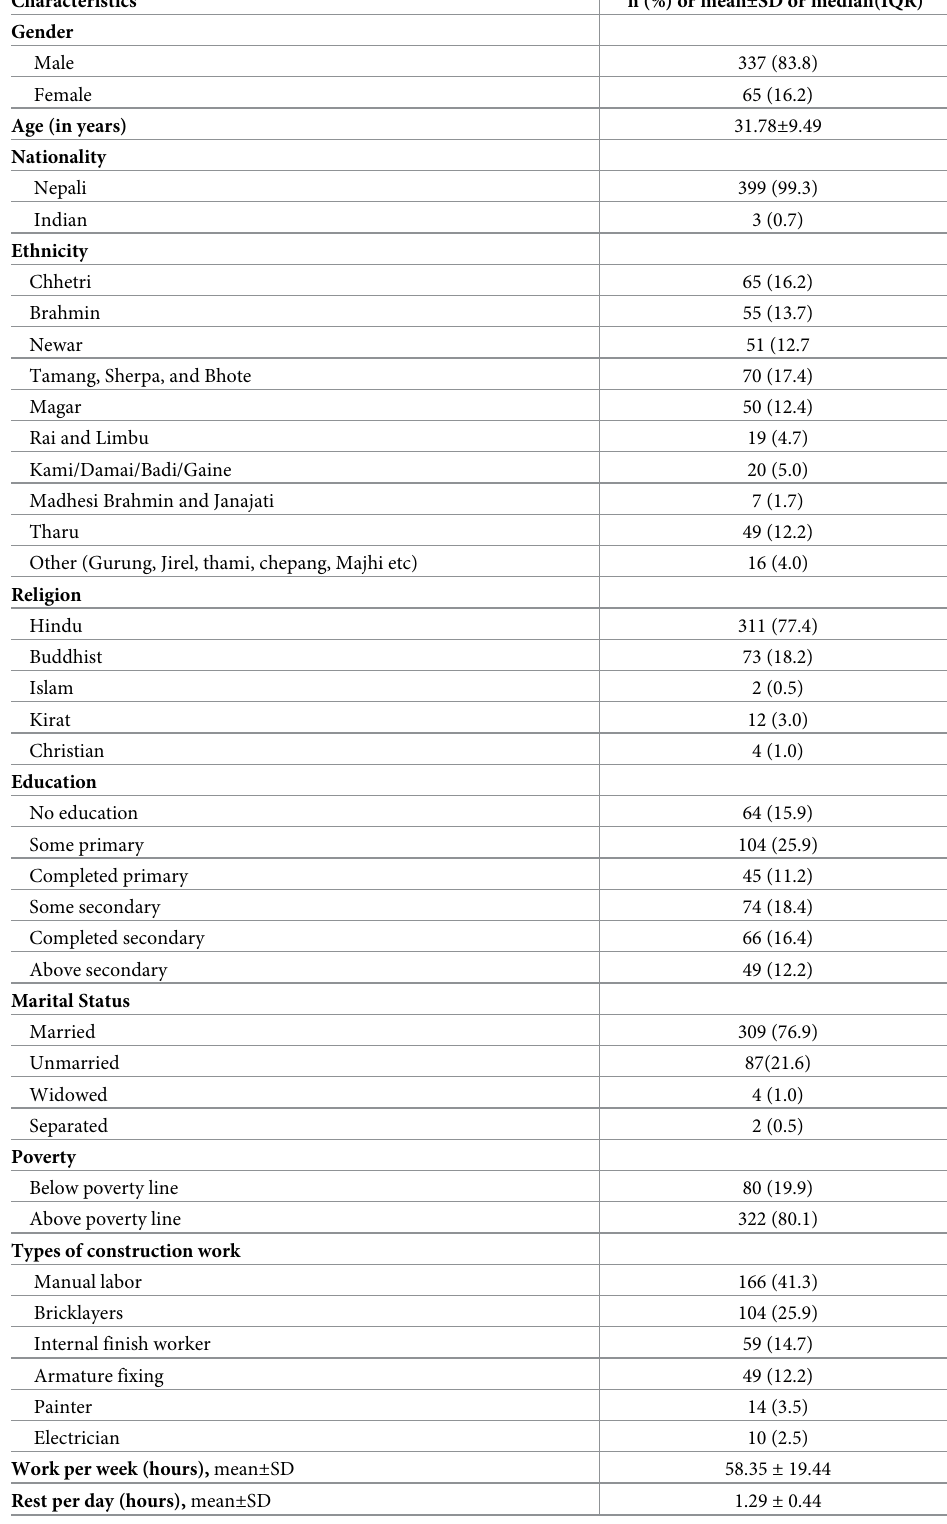
Table 1. Socio-demographic and occupational characteristics of the construction workers (N = 402).